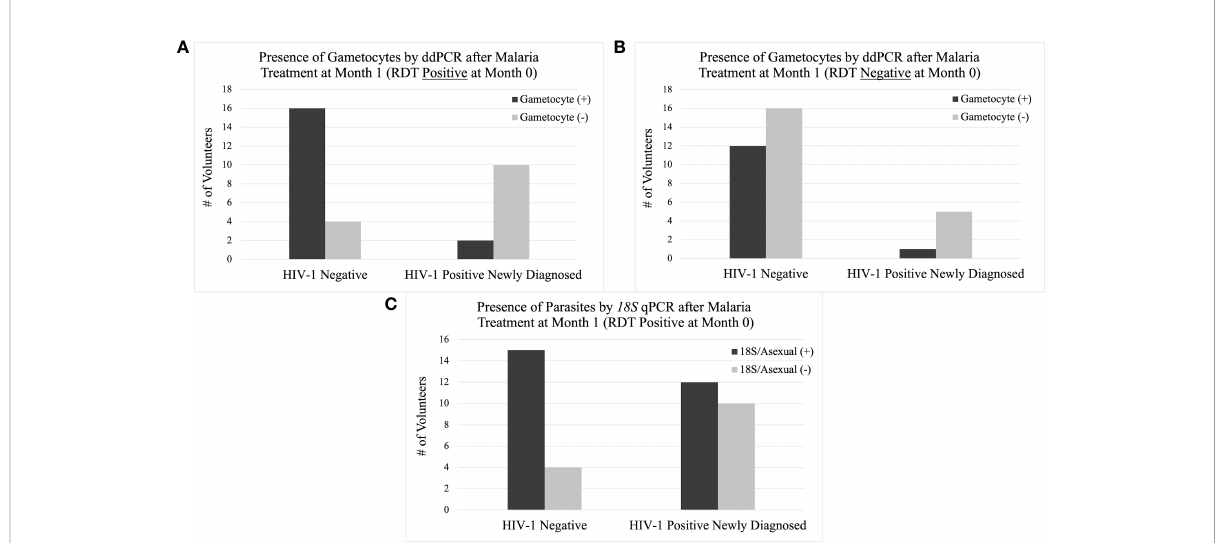
FIGURE 10 Presence of Gametocytes and Asexual Parasites at Month 1 by Study Group. The column graph on the top left (A) shows the presence of gametocytes by ddPCR after AL treatment at month 1 if the volunteer was positive for malaria by RDT at month 0. The column graph on the top right (B) shows the presence of gametocytes by ddPCR without AL treatment at month 1 if the volunteer was negative for malaria by RDT at month 0. The column graph on the bottom center (C) shows the presence of asexual parasites by 18S qPCR after AL treatment at month 1 if the volunteer was positive for malaria by RDT at month